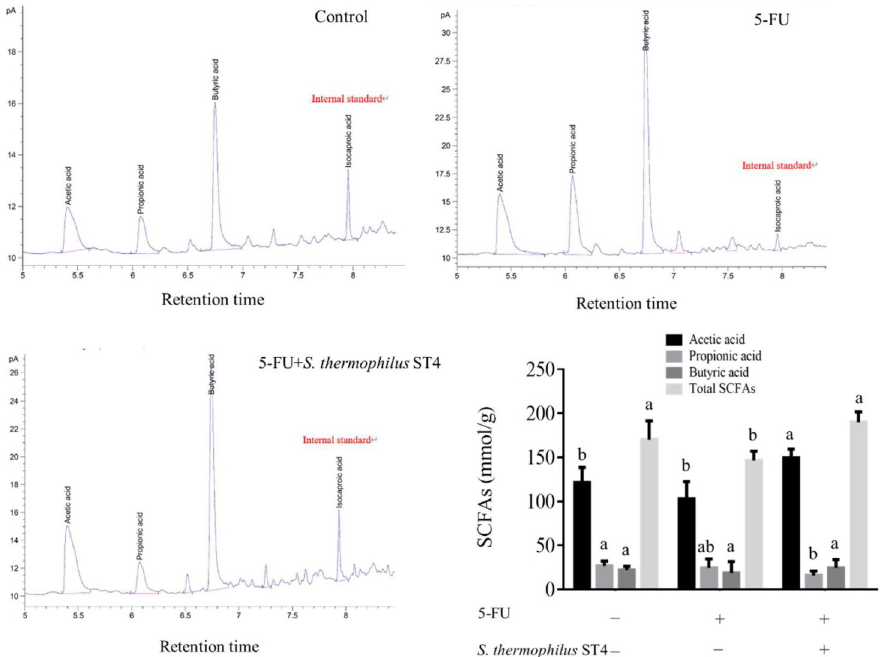
Fig 4. S . thermophilus ST4 promotes SCFAs production of the 5-FU-induced mouse. (A-C) HPLC profiles and (D) concentration ( μ mol/g) of SCFAs in feces collected from three groups. Isocaproic acid as an internal standard in HPLC. Data are present as mean ± SD of 5 mice. The data with different superscripted letters are significantly different based on the one-way ANOVA ( p < 0.05).